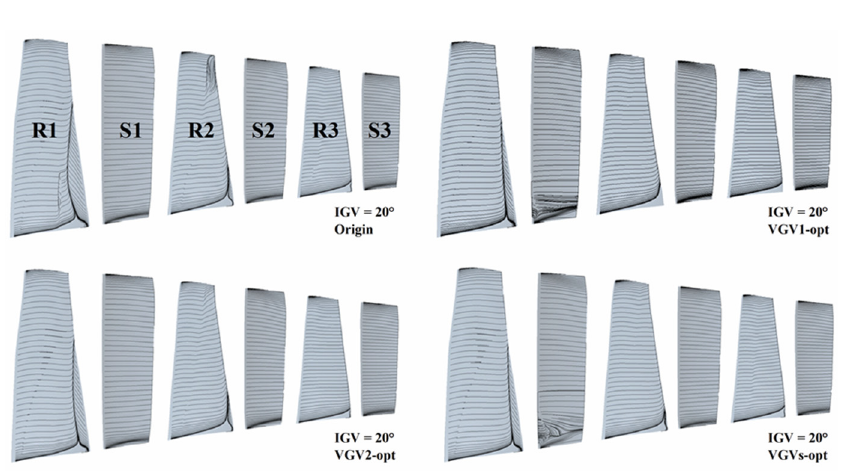
Figure 25. Isentropic Mach number distribution (VGV joint adjustment). ( a ) R1; ( b ) R2; ( c ) R3.